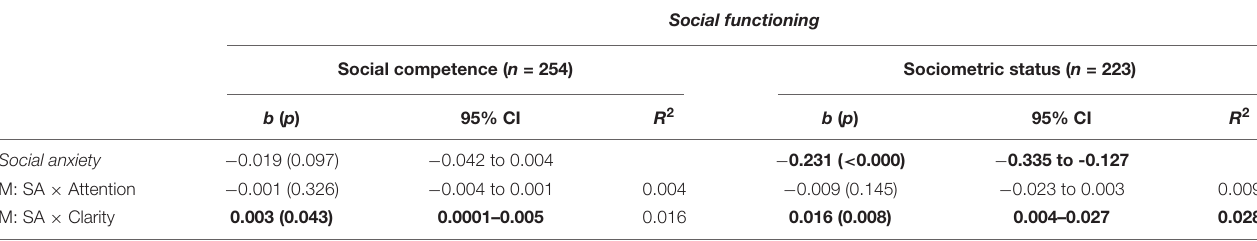
TABLE 2 | Social anxiety (conditional) effects and self-mentalizing moderation effects on social function.